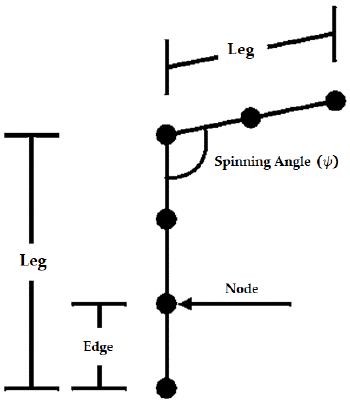
Figure 1. Correlation of Edge, Node, and Legs along with spinning angle 𝜓.